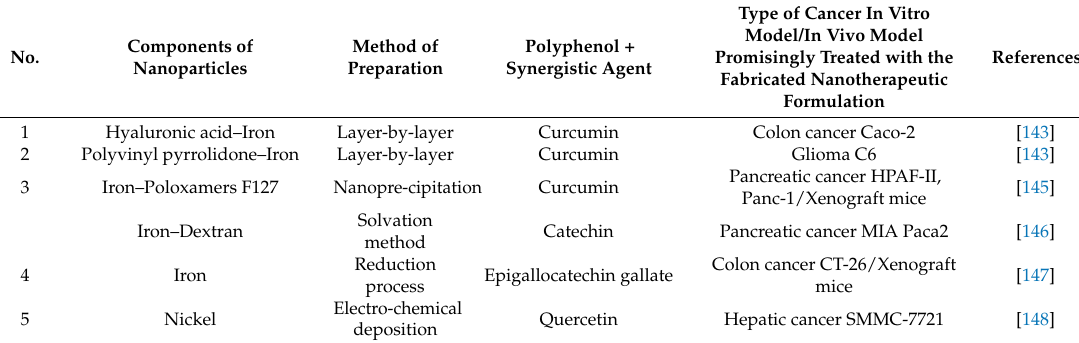
Table 7. Polyphenol-loaded magnetic nanoparticles for the treatment of cancer.